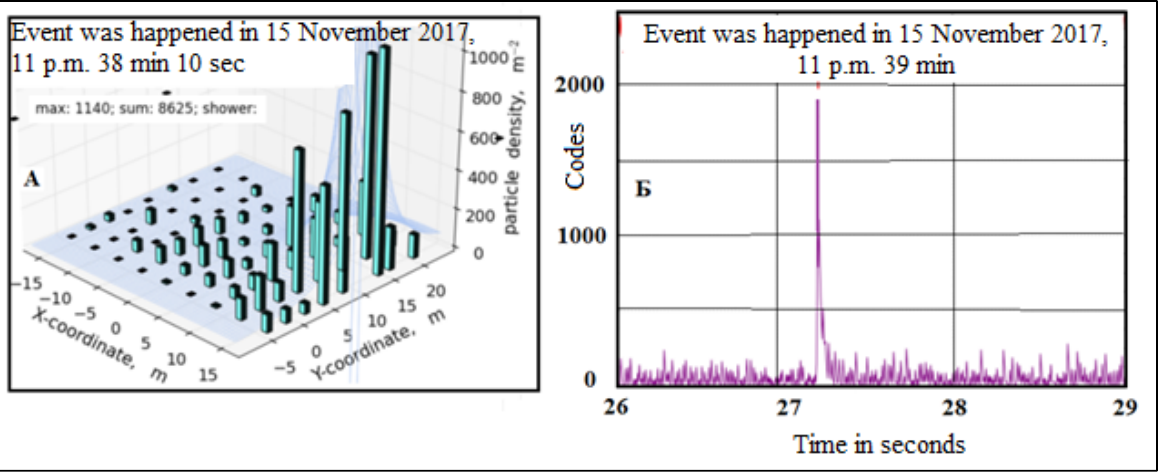
Figure 8. Results obtained on November 15, 2017. Acoustic signal detection vs. time ( A ). Distributed density of particles flux during EAS ( B ).